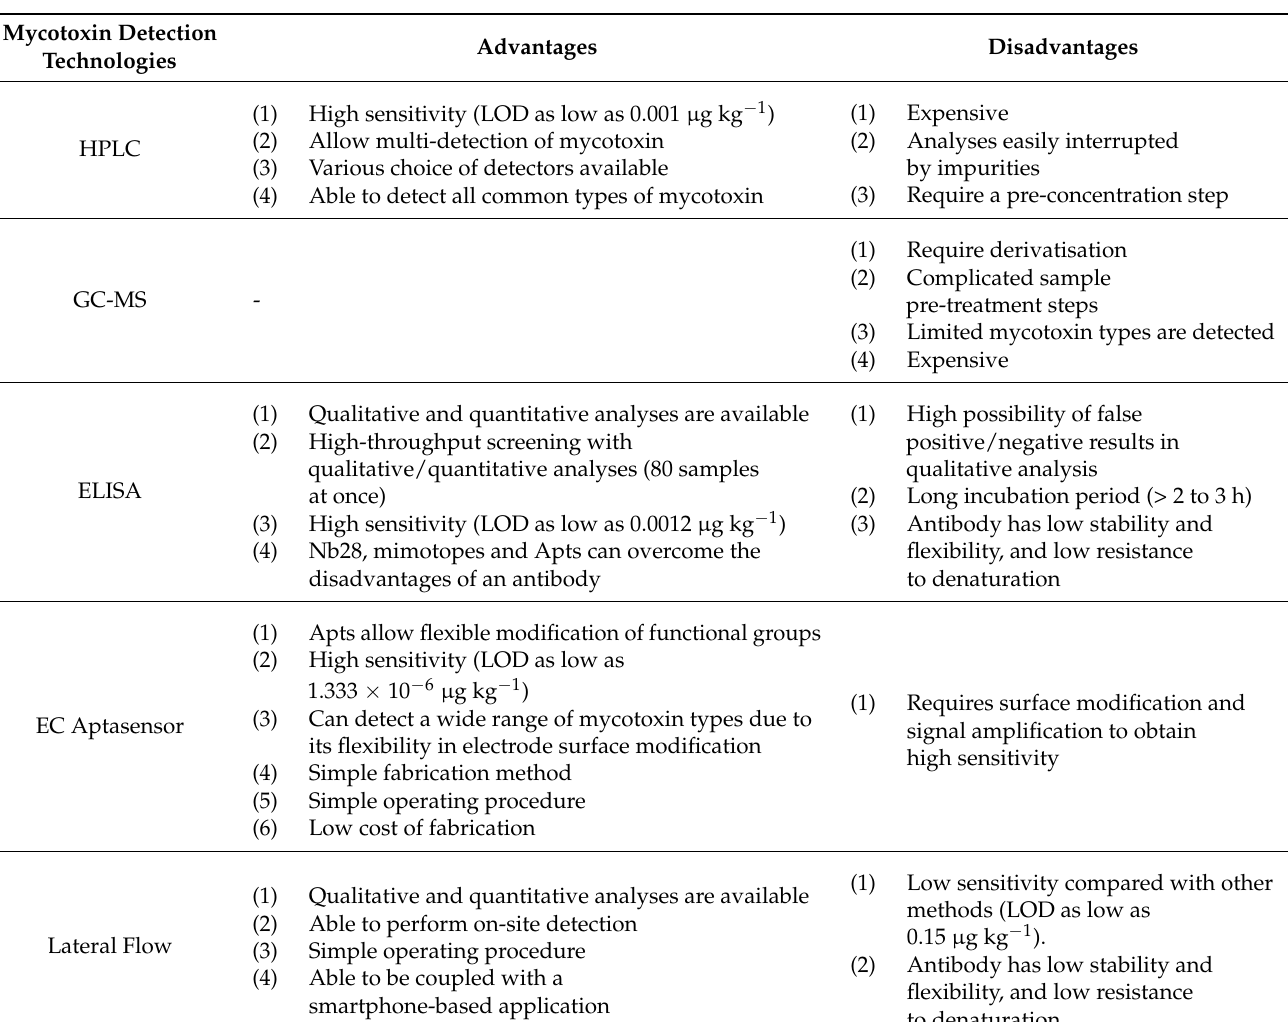
Table 7. Summary of current technologies with respect to their advantages and disadvantages for mycotoxin detection. Mycotoxin Detection